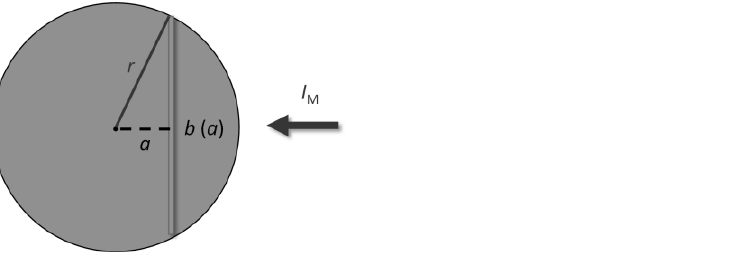
Figure 1. View on the circular base plane of a cylindrically shaped grain for the determination of the length b ( a ). The measurement current I M passes through the cylindrical surface.